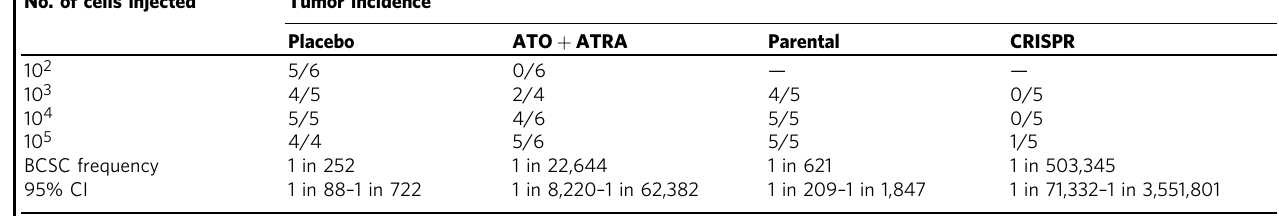
Table 1 Tumor incidence in limiting dilution assay No. of cells injected